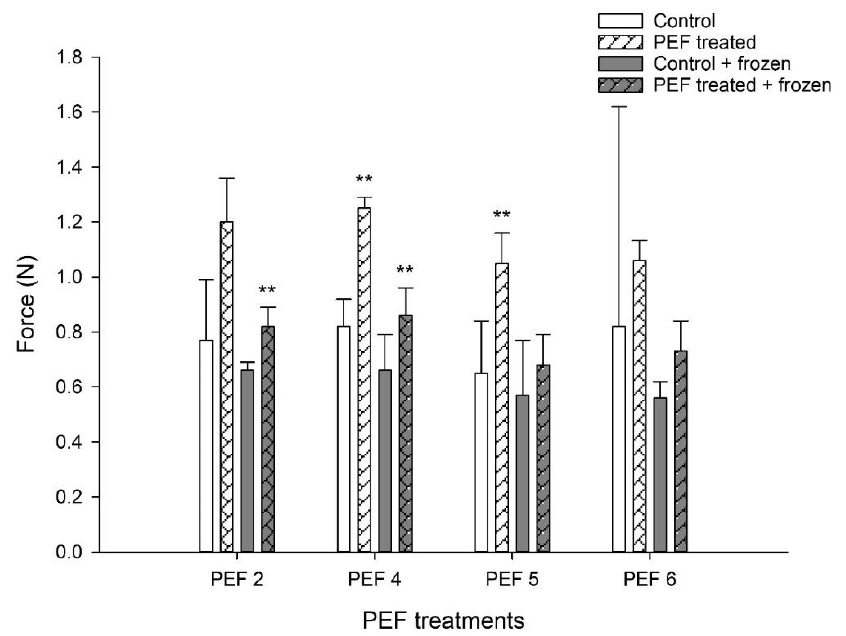
Figure 3. Effect of PEF pre-treatment of the starter culture on the stiffness of set yogurt. Force (N) is the maximum force applied on the surface of the yogurt until the first break. Yogurts were made with freshly PEF-pre-treated cultures (PEFx-D) or with cultures which were flash-frozen and stored at −20 °C for 14 days after PEF pre-treatment (PEFx-FF). PEF2, PEF4, PEF5 and PEF6 represent different PEF parameters. The bars indicate the mean values of three independent experiments ± 1 standard deviation. ** p < 0.05 (paired t -test) compared with the respective control (control vs. PEF-treated; control + frozen vs. PEF-treated + frozen).